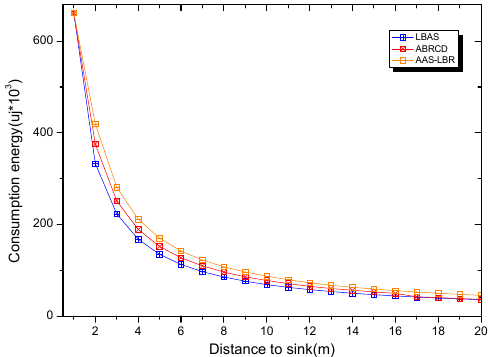
Figure 30. Energy consumption of nodes 400–500 m away from sink under 𝑇 = 60 and r = 28 m .